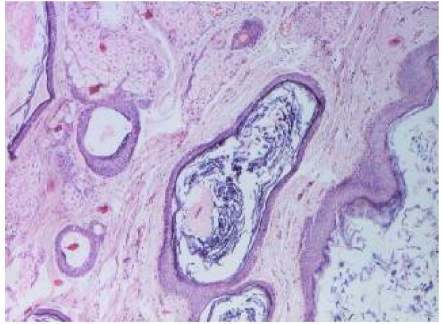
Figure 8. Struma ovarii with teratoma. HE, 10 × .